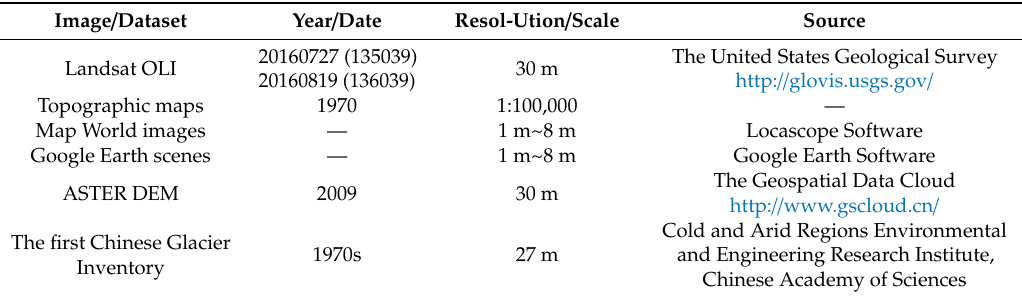
Table 1. Description of the data used in this